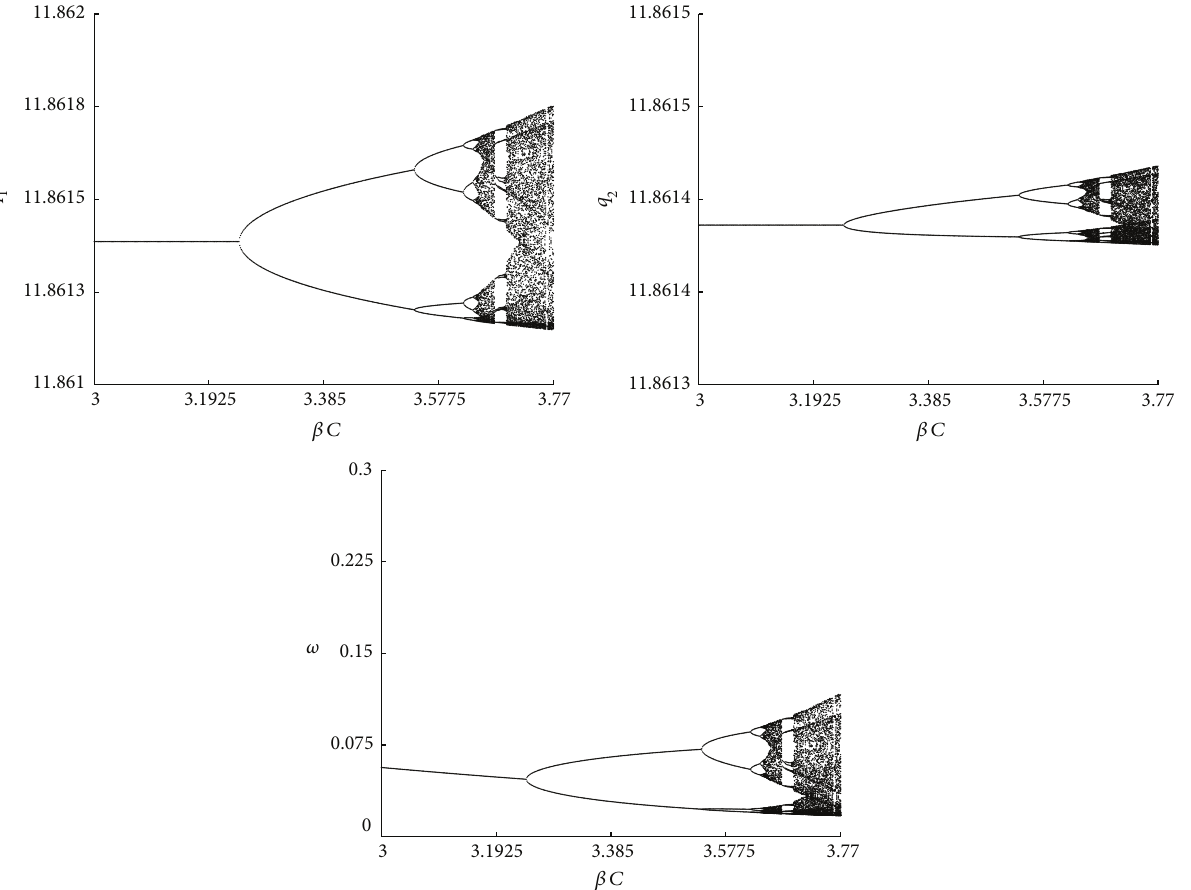
Figure 6: Bifurcation diagrams of quantities 𝑞 1 and 𝑞 2 and fraction 𝜔 with respect to the evolutionary pressure 𝛽 . Increasing 𝛽 leads to